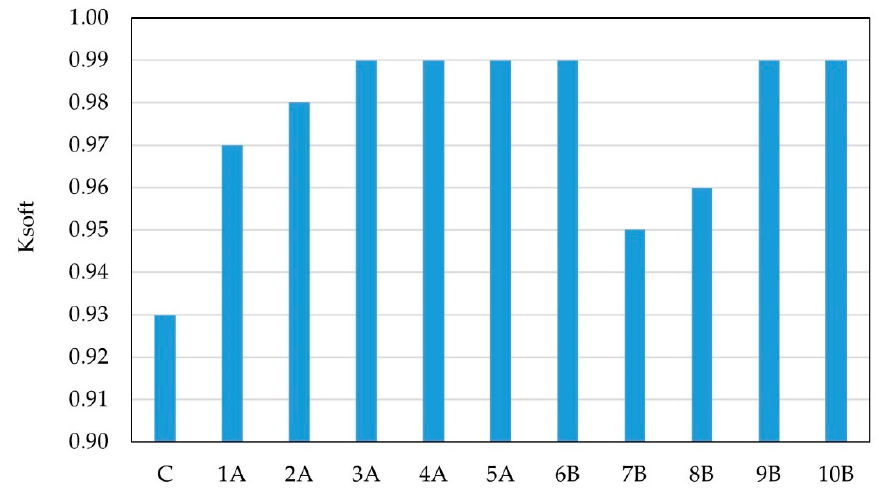
Figure 11. Softening coefficients of experimental compositions of geopolymer fine-grained concrete.